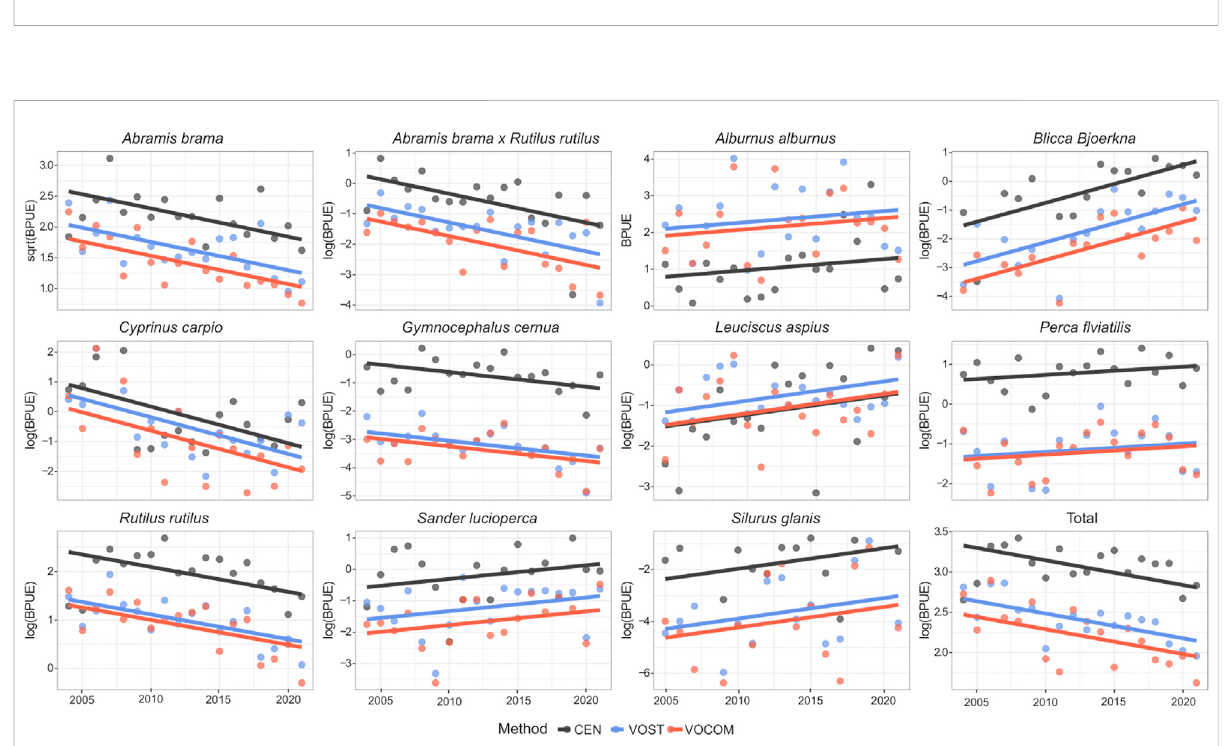
FIGURE 6 Temporal trends of BPUEs based on ANCOVA model fi ts of transformed data determined by the three methods (CEN, VOST and VOCOM) for the dominant fi sh species and the whole fi sh community in the Ř ímov Reservoir (Czech